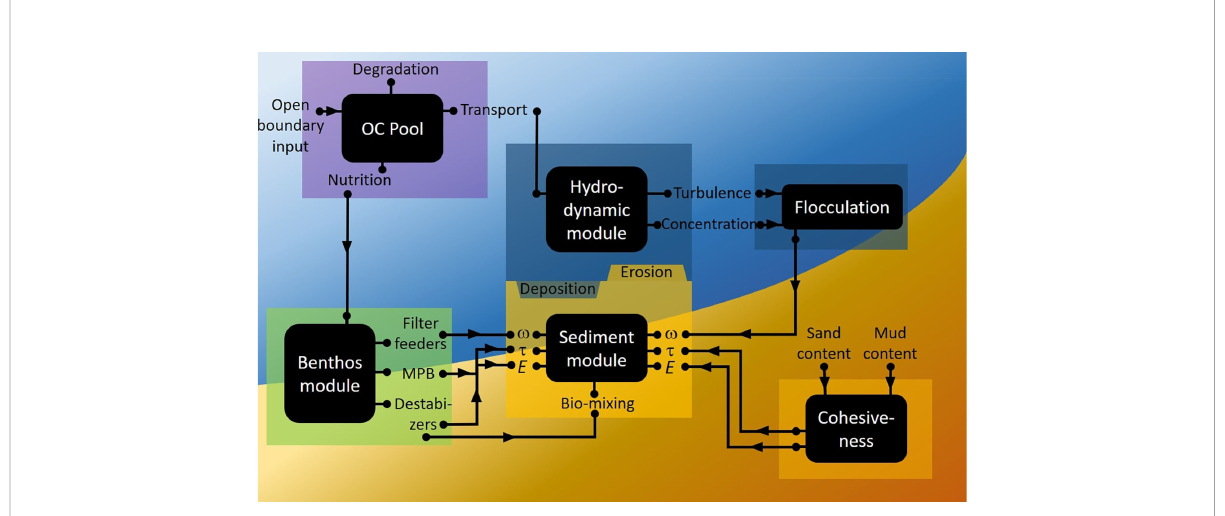
FIGURE 2 Schematic overview of numerical model components and their coupling. The hydrodynamic and sediment modules are from the SCHISM model, while other components were integrated to the SCHISM model as module (benthic fauna module) or subroutines ( fl occulation of cohesive sediments and organic detritus). Exchange of parameters between the model components is indicated by the